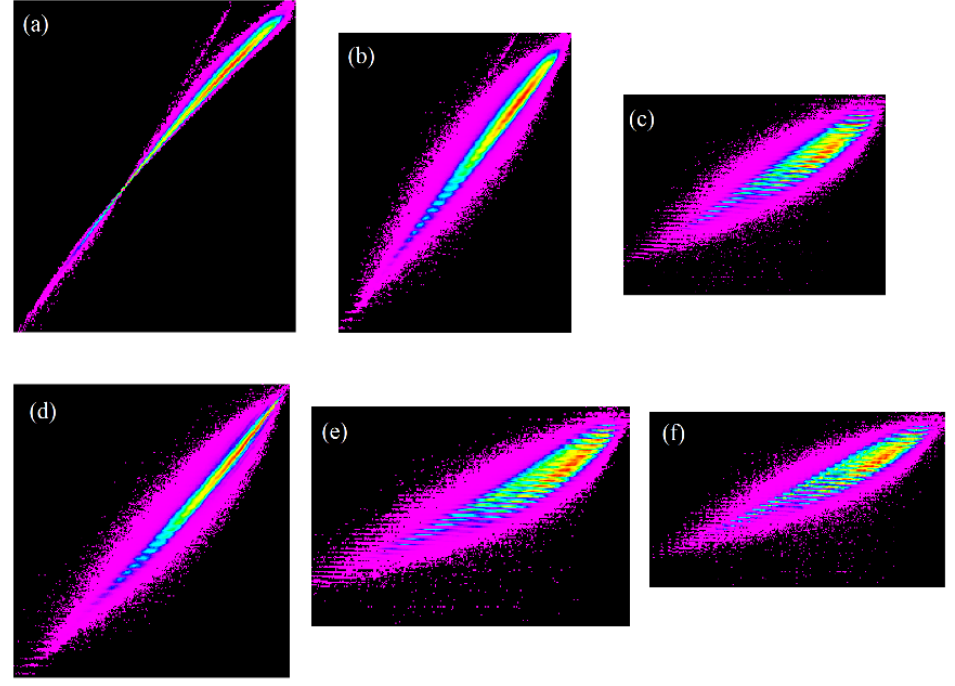
Figure 12. Scatterplot of evaporative fraction estimated for 5 August 2001 using different ET models for grassland showing ( a ) METRIC model ( ET r F ) versus SEBAL model ( EF ); ( b ) METRIC model ( ET r F ) versus SEBS model ( Λ ), ( c ) METRIC model ( ET r F ) versus SSEBop model ( ET f ); ( d ) SEBAL model ( EF ) versus SEBS model ( Λ ); ( e ) SEBAL model ( EF ) versus SSEBop model ( ET f ); and ( f ) SEBS model ( Λ ) versus SSEBop model ( ET f ). Axes values are such as diagonal line represents 1:1 line. Different colors in the scatterplots indicate density of points with red being the highest density and magenta being the least density.